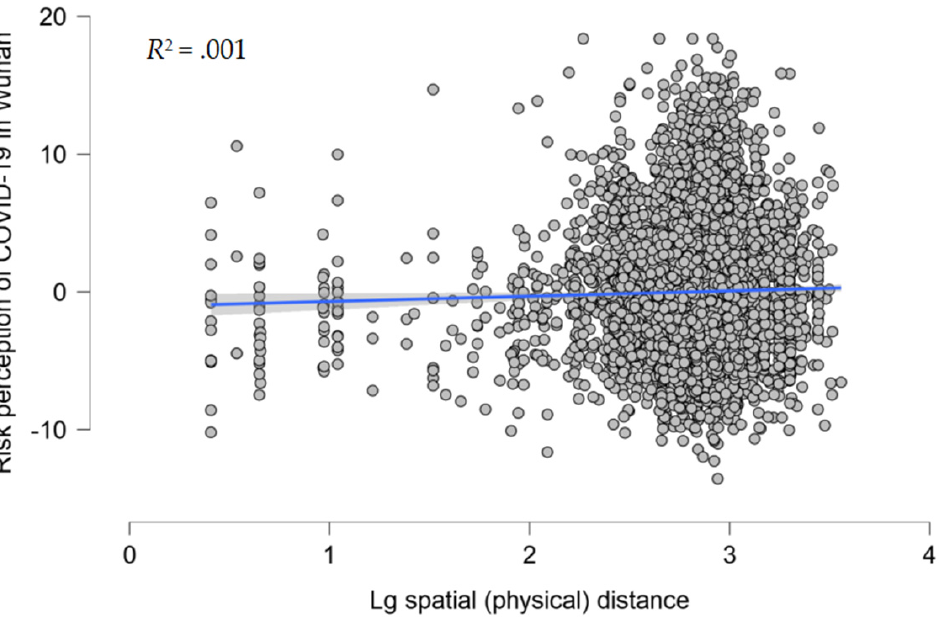
Figure 5. Scatterplot of the log transformation of spatial (physical) distance against the risk perception of COVID-19 in Wuhan, with the best-fitting regression line in the middle; N = 7283, r = .027, R 2 = .001.